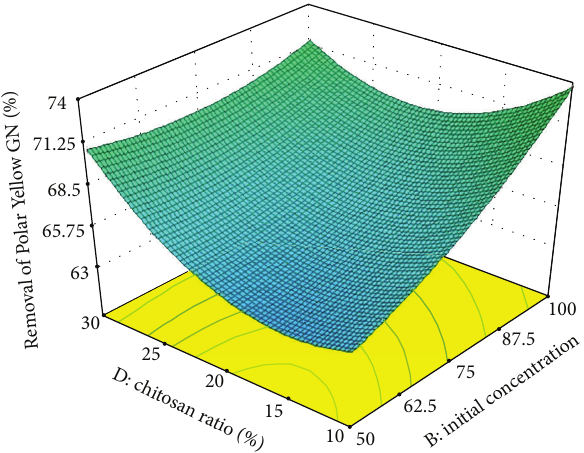
Figure 8: 3D surface plot of the dye removal for the chitosan ration and initial dye